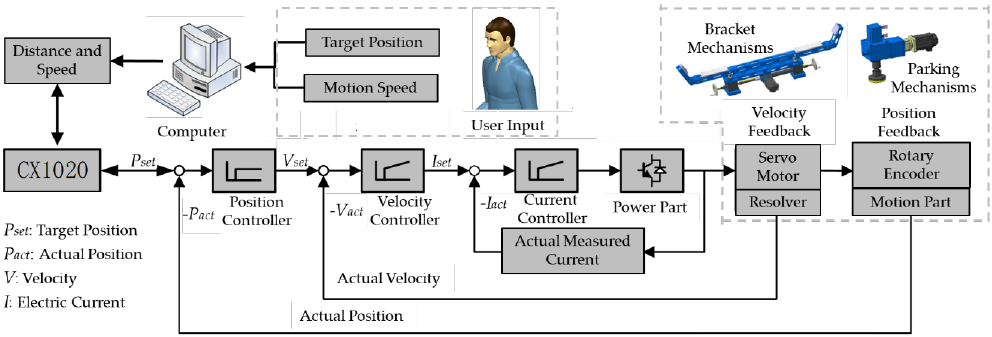
Figure 2. Working principle of the supporting system.